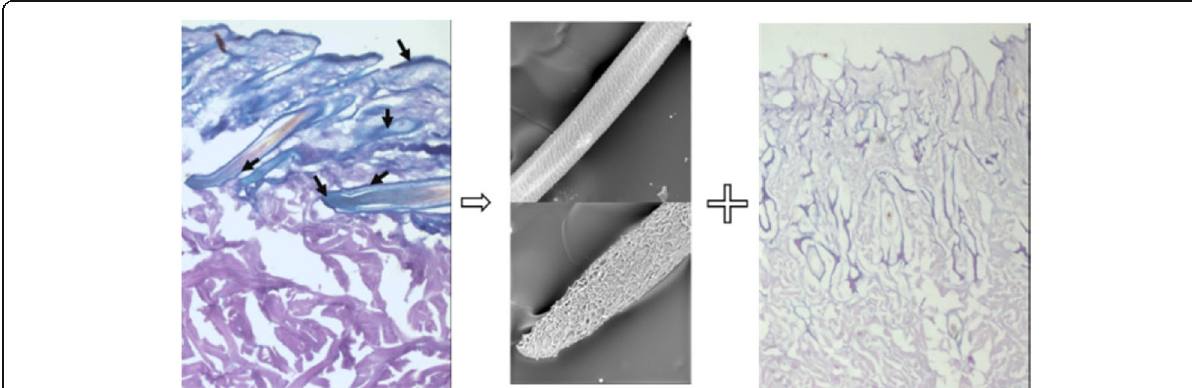
Fig. 4 The mechanism and unhairing effect of a protease and a glycosidase. The PGs (stained purple-blue which was indicated in the black arrow) in the hair root bulb, epidermis and surrounding the follicle and collagen fibers in the papillary layer were almost all removed after unhairing by protease and